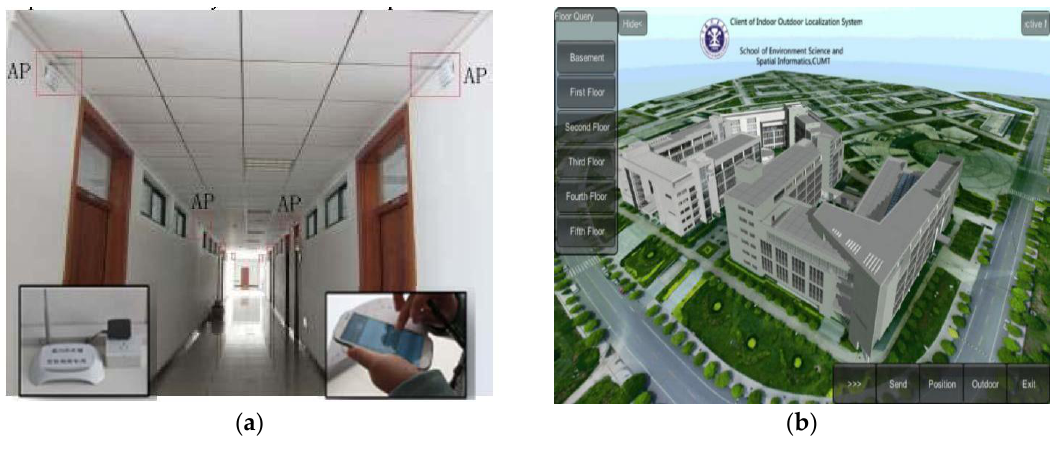
Figure 1. Experimental site. ( a ) Floor scene graph of the fourth floor; ( b ) 3D model of the experimental site.